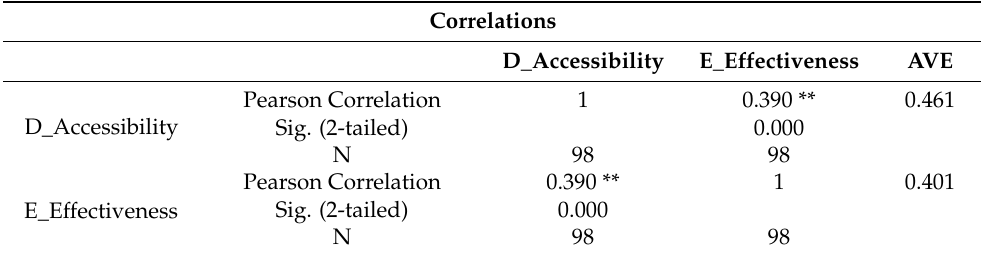
Table 7. Correlations between accessibility and effectiveness.